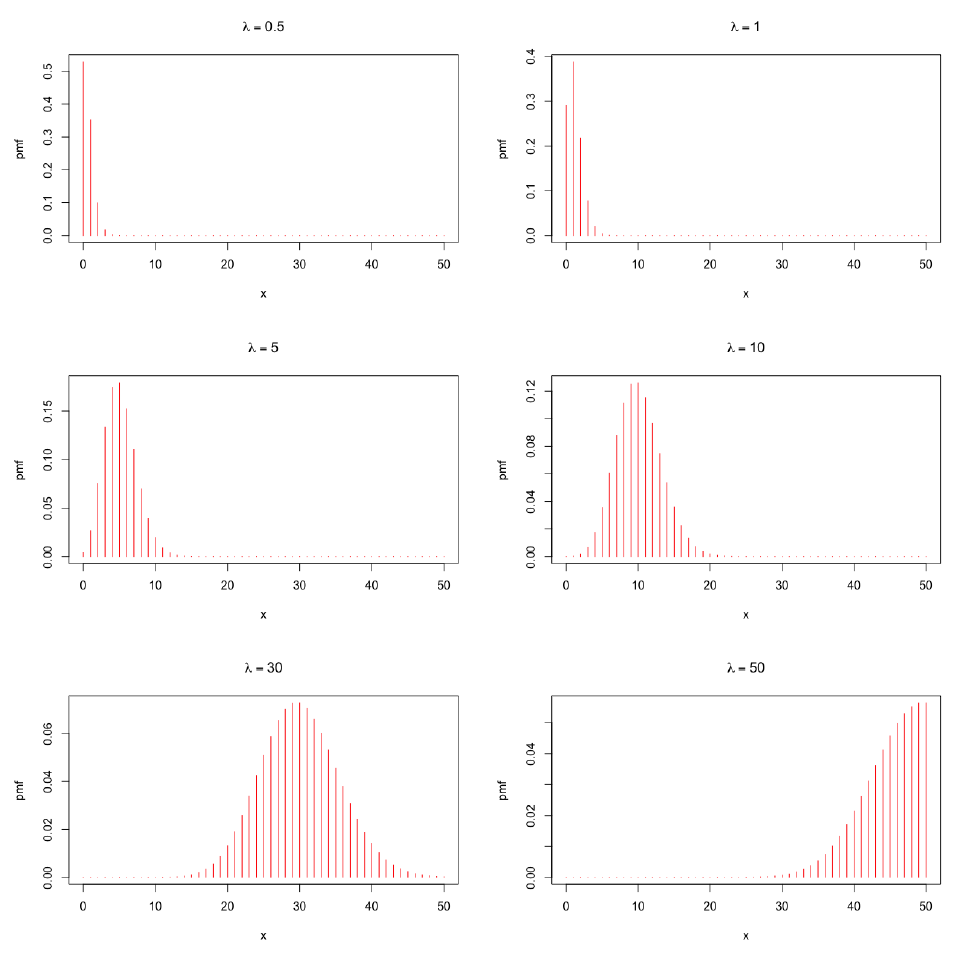
Figure 1. Pmf of the SP ( λ ) distribution for different parameter